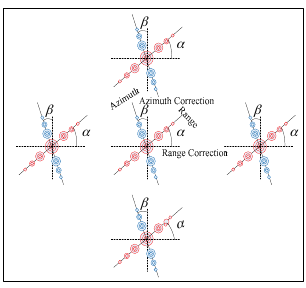
Figure 5. The schematic diagram of range and azimuth sidelobes for squint SAR image.